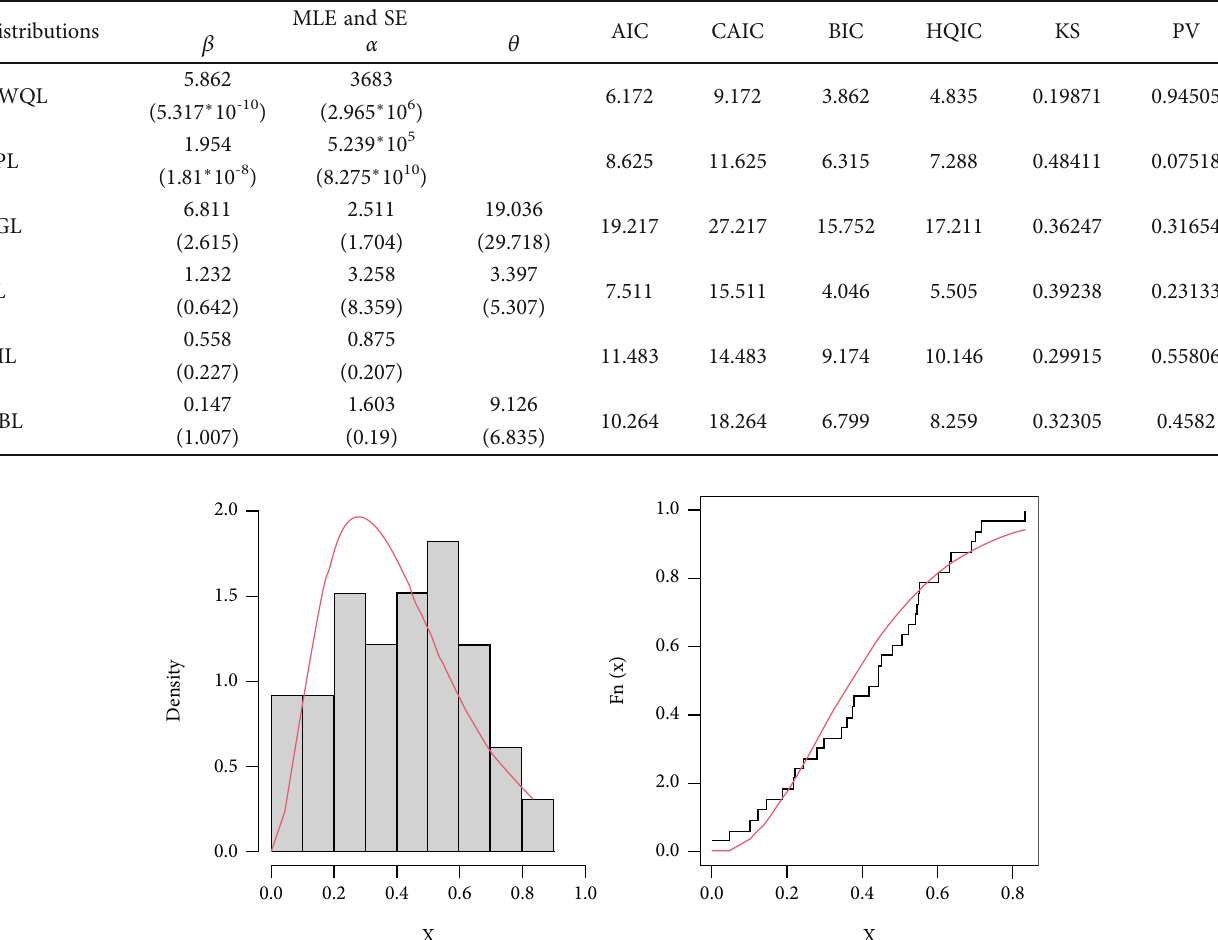
Table 12: The MLEs, SEs, and measures of fi tting for the second data set.